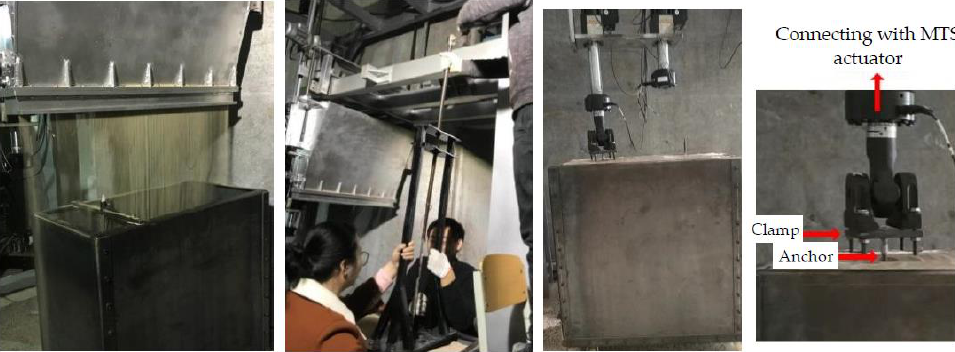
Figure 2. Sand preparation, installation and connection with actuator of anchors.